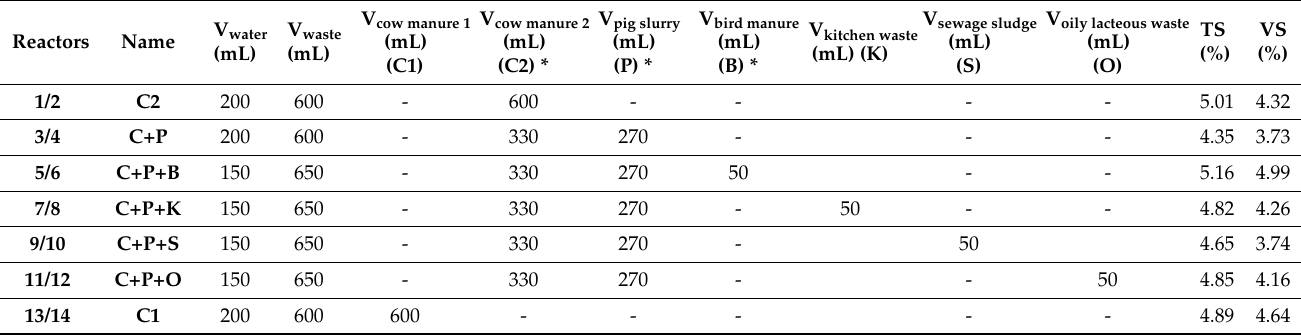
Table 1. Description of experimental design: ratio of